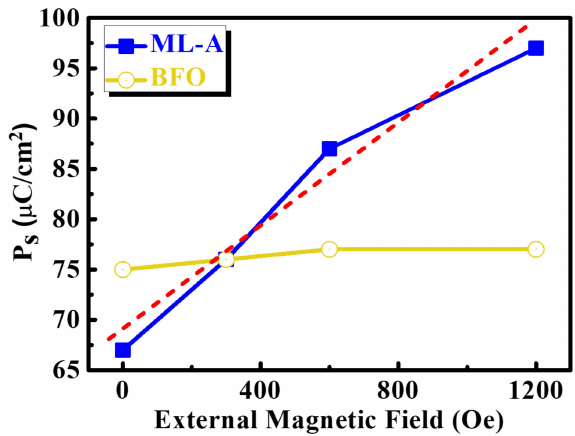
Figure 6. The dependency of P s with different external Magnetic (M) inputs on the pure 100 nm BiFeO 3 (BFO) and our designed multi- layer (BaTiO 3 (BTO)/BiFeO 3 (BFO)) structures for Condition A (ML-A).